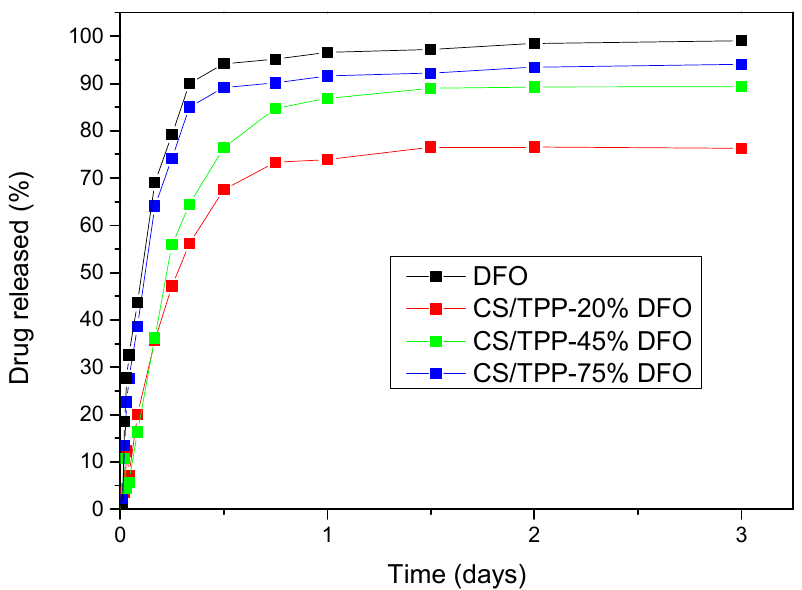
Figure 8. Kinetics of DFO release from CS nanoparticles (NPs) with variable DFO content.